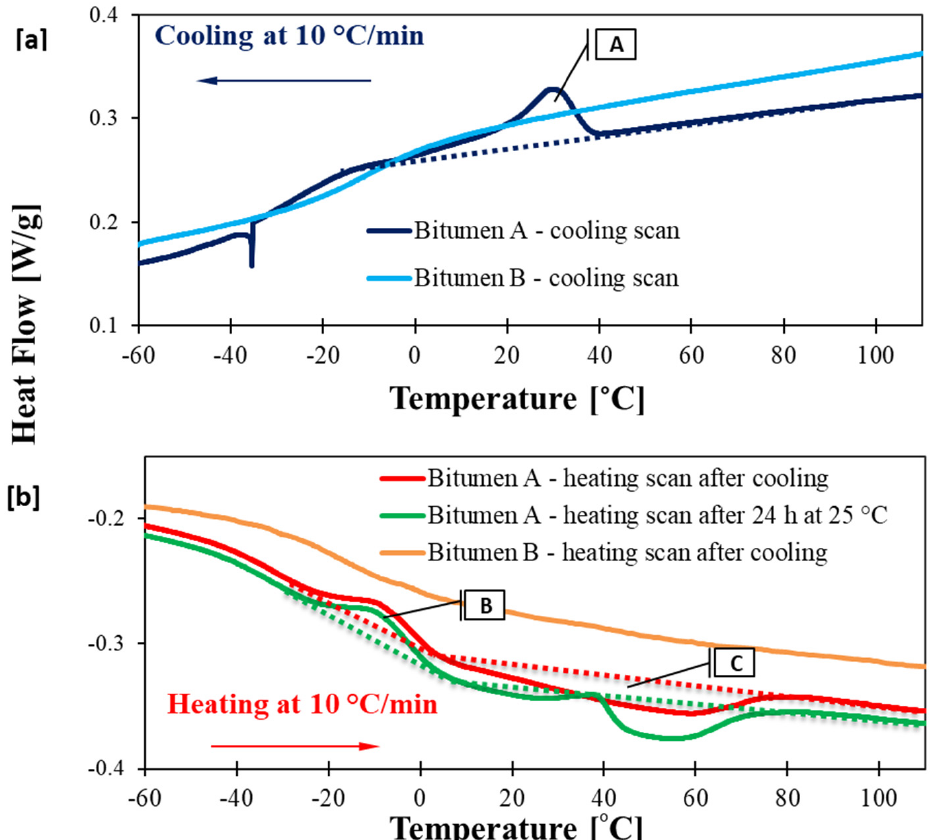
Figure 2. DSC cooling scan ( a ) and DSC heating scan for bitumen A and B and heating after annealing at 25 °C for 24 h for bitumen A ( b ).